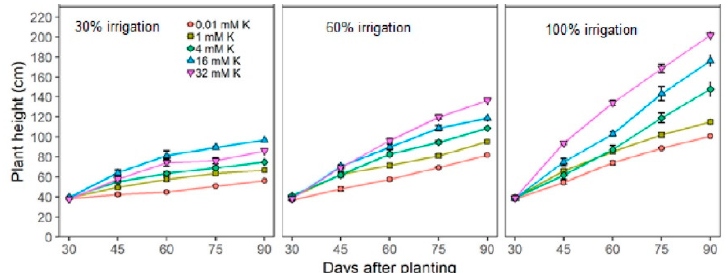
Figure 4. Plant height of young cassava plants in response to deficit irrigation and K fertigation. The treatments were initiated 30 days after planting and lasted 60 days. The data from four separate experiments were combined and shown as the means ± standard error of 4 to 16 replicate plants.